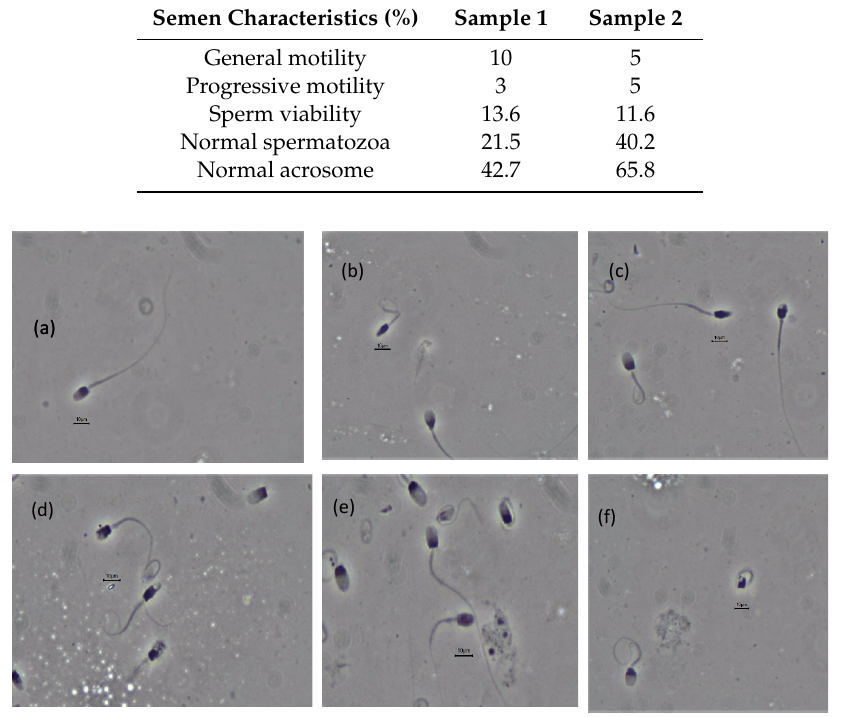
Figure 4. Normal acrosome ( a ), irregular distribution of acrosomal material ( b and c ), fragmented acrosome ( d ), loss of acrosome ( e ), and detached acrosome ( f ). Table 5. Sperm characteristics in two different frozen-thawed semen from Leopard 1. Sample 1 was collected on January 15, 2018 and Sample 2 was collected on February 28, 2018. Both were stored for more than 2 years before thawing and evaluation.